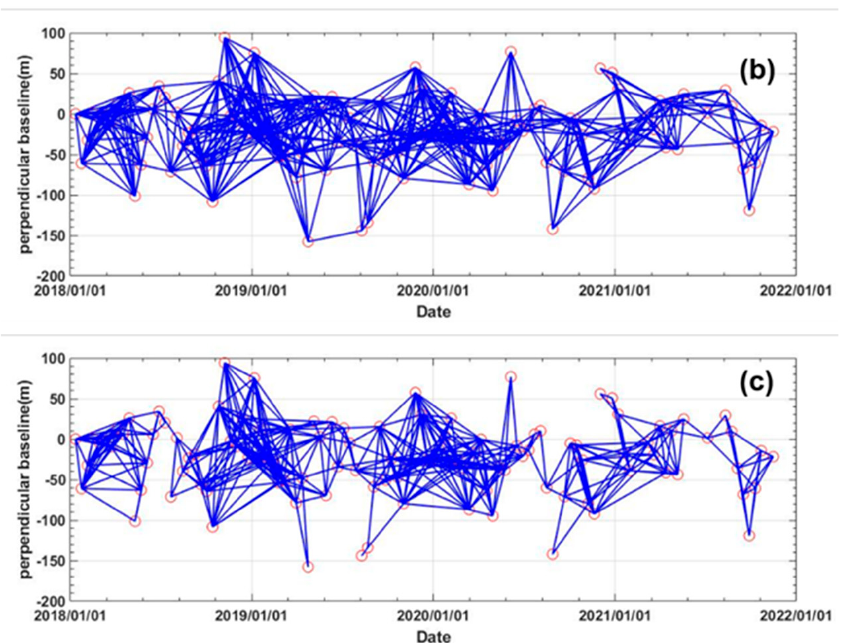
Figure 5. Distribution of interferograms in a temporal/perpendicular baseline domain. ( a ) Set of available interferograms generated by setting a maximum temporal baseline separation of 150 days and spatial baseline of ±150 meters. ( b ) Optimal network of interferograms retrieved by applying the proposed InSAR automatic selection method. ( c ) Reduced network of interferograms at boundary condition where one single data pair exists that connects the group of interferograms to form a single set of data. Note that ( b , c ) refer to the condition on minimum average spatial coherence of selected interferograms of 0.636 (P1 in Figure 4) and 0.704 (P2 in Figure 4).